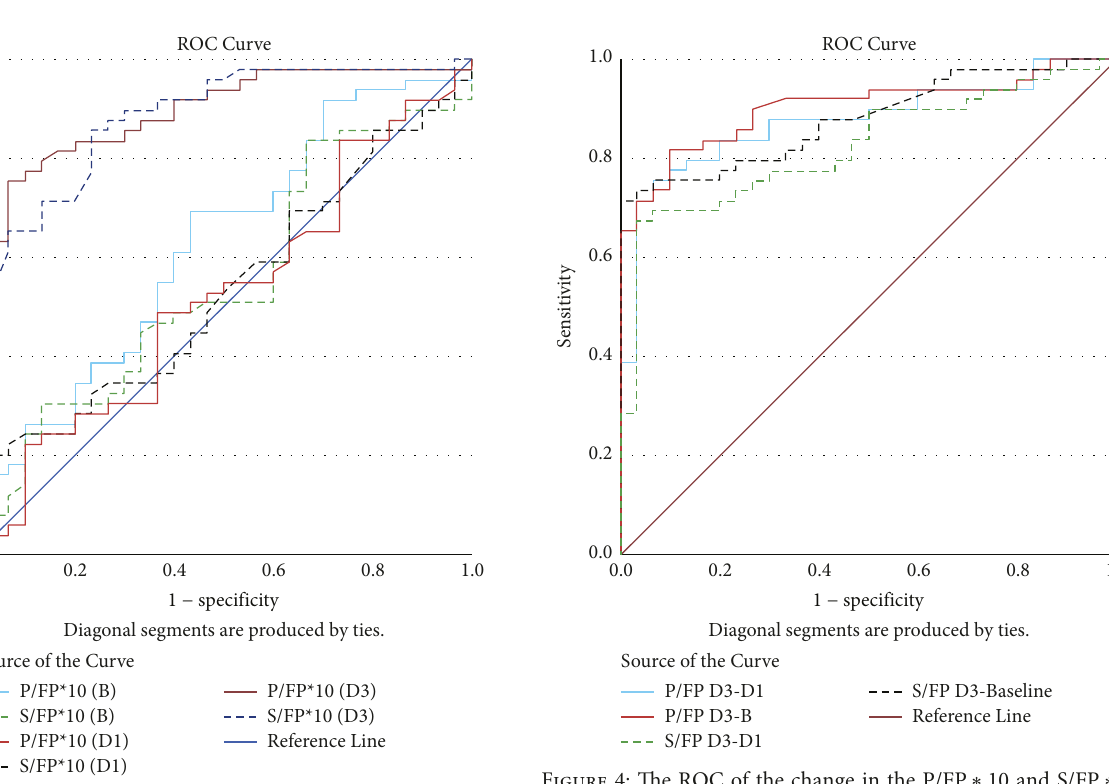
Figure 3: Receiver operating characteristic curves to predict survival for P/FP ∗ 10 and S/FP ∗ 10 at baseline, day 1, and day 3. The P/FP ∗ 10 (D3) has an AUC of 0.900 and a cut-off ≥ 257.5 to predict survival, followed by S/FP ∗ 10 (D3) with a cut-off ≥ 243.75 and an AUC of 0.872.